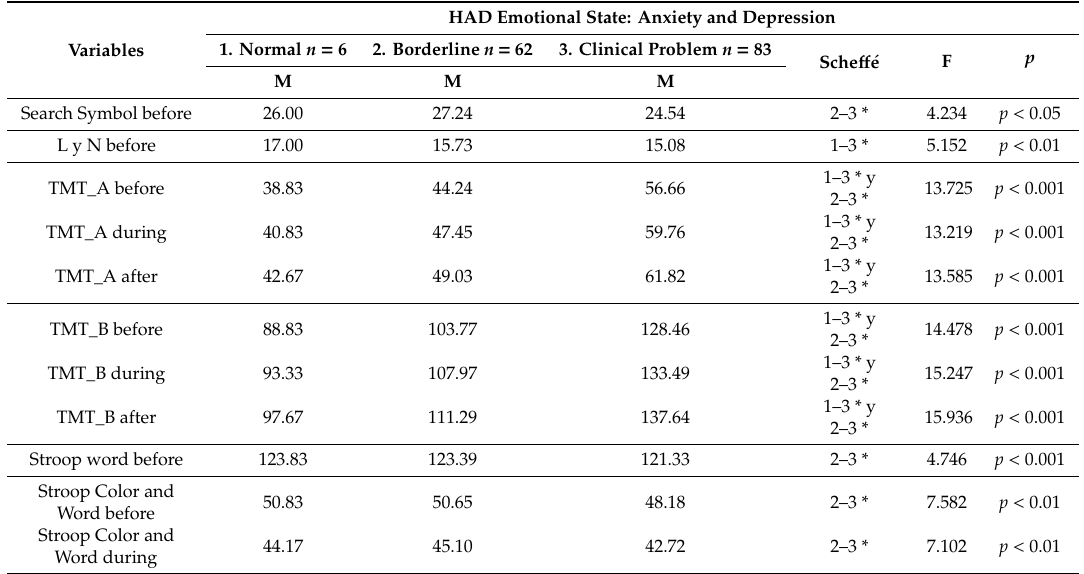
Table 3. Influence of anxiety and depression before treatment in the tests